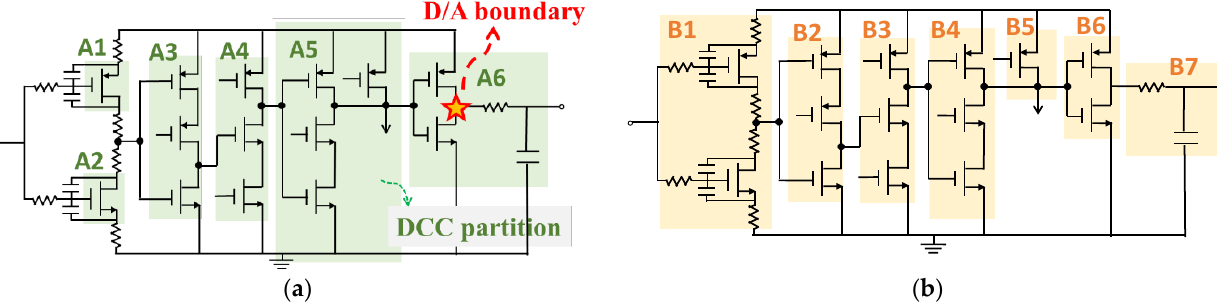
Figure 1. ( a ) Unacceptable ( b ) Expected identification results for TSPC (true single-phase clock) logic with reset control and RC filter.